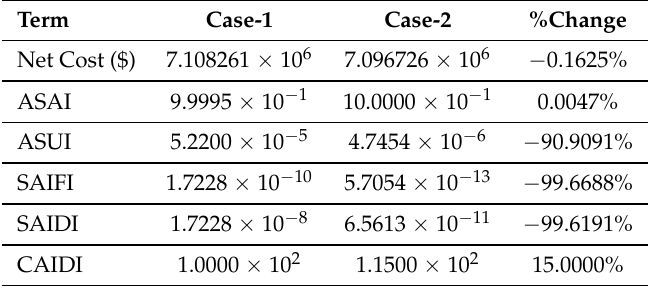
Table 8. Comparison between the two